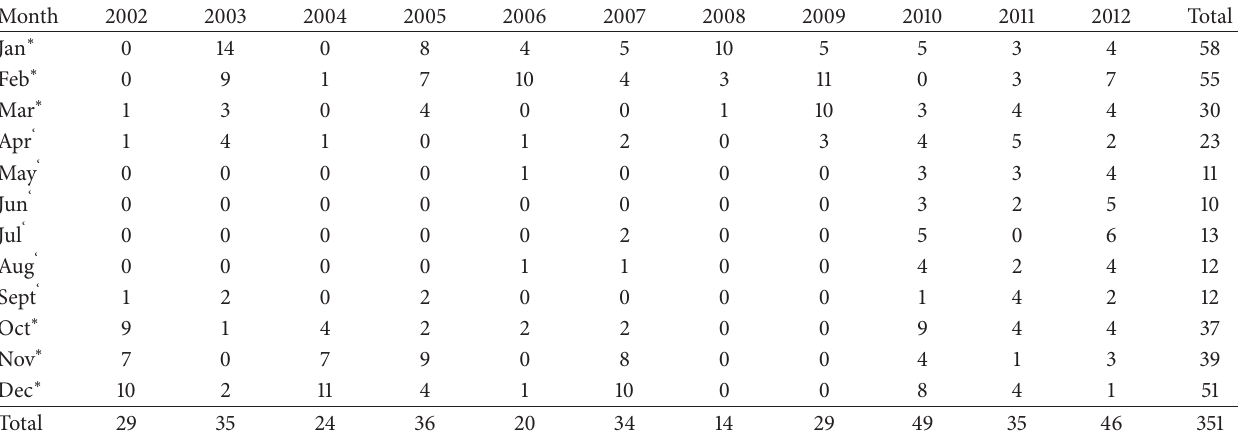
Table 2: Amount of fire occurrence per year and month on eucalyptus plantation of the Bahia Specialty Cellulose company.